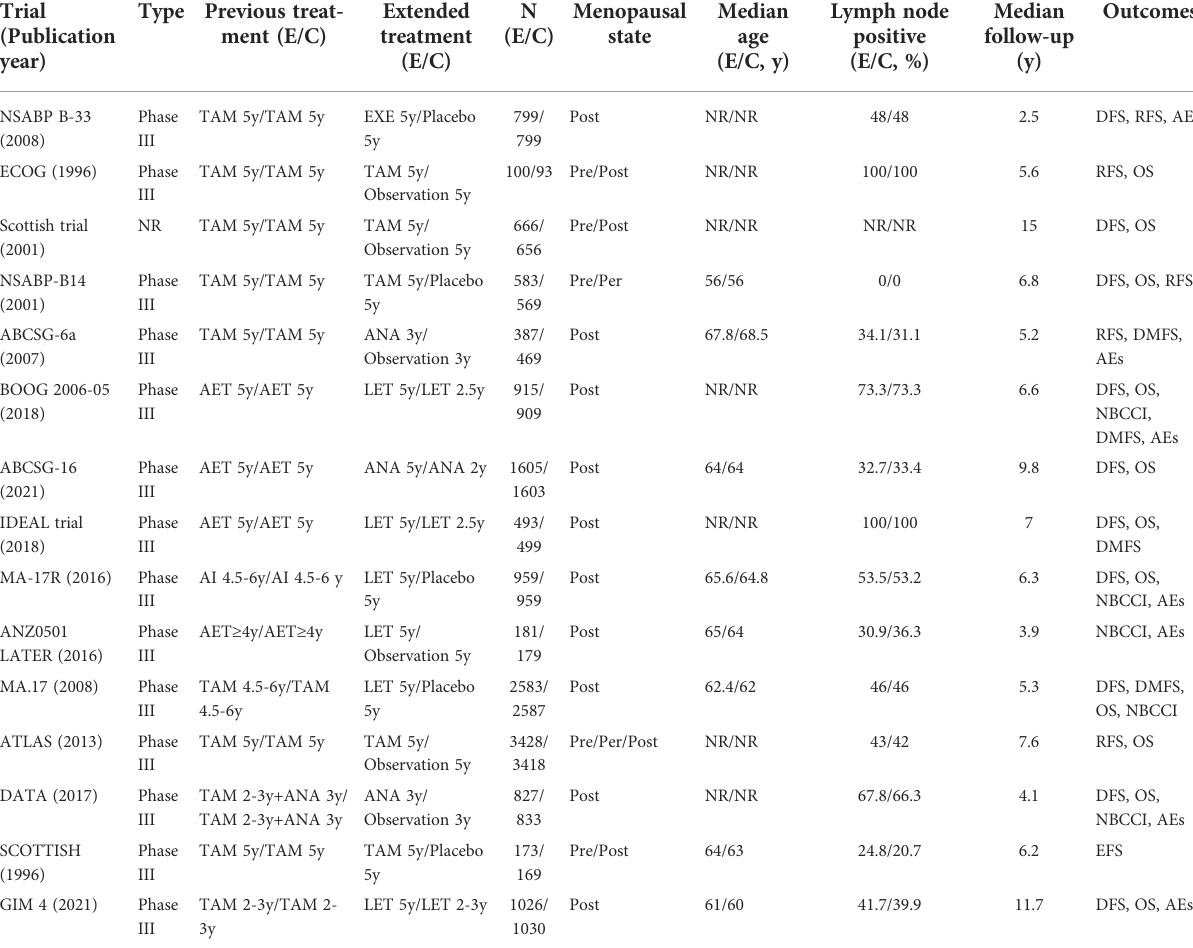
E experimental arm,C controlarm, Nnumber ofpatients, y year,NR notreported, TAMtamoxifen, EXEexemestane, Postpostmenopausal, Prepremenopausal, Perperimenopausal, DFS disease-free survival, OS overall survival, RFS relapse-free survival, AEs, adverse events, ANA anastrozole, LET letrozole, AET adjuvant endocrine therapy, AI aromatase inhibitor, DMFS distant metastatic-free survival, NBCCI new breast cancer cumulative